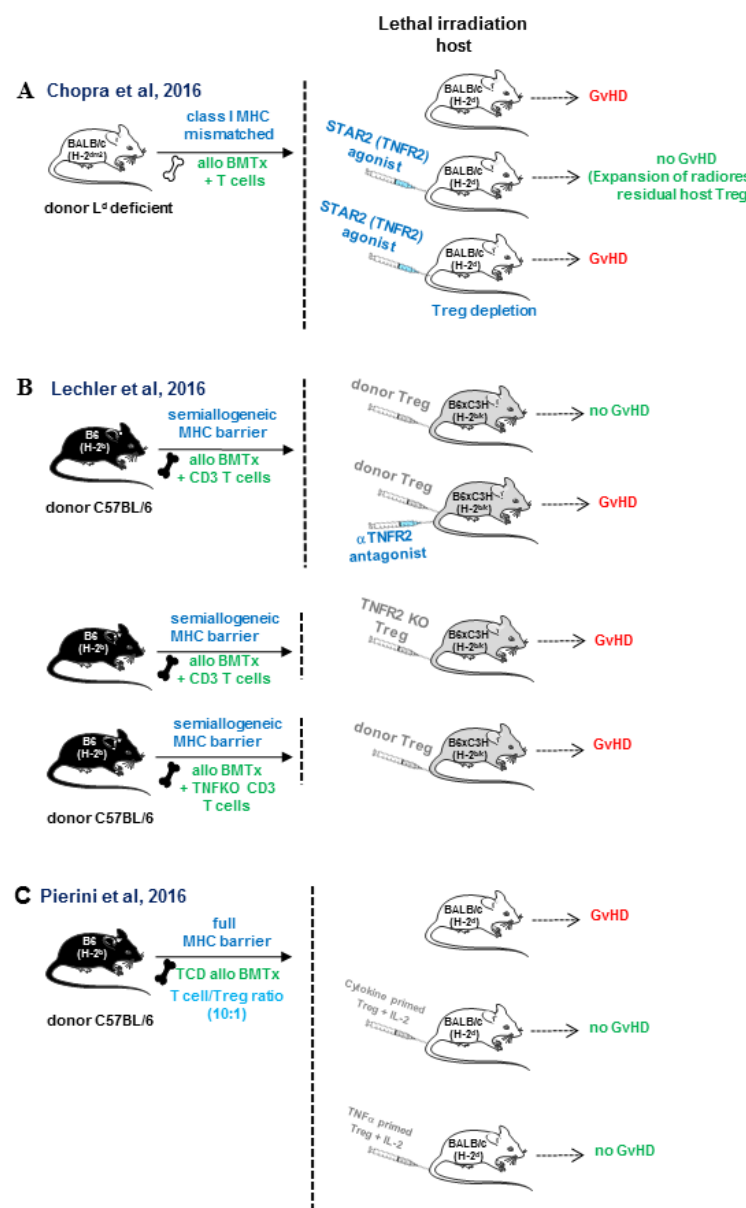
Figure 4. In vivo TNFR2 triggering protects against GvHD by enhancing donor and host Tregs expansion in allogeneic bone marrow transplantation across di ff erent histocompatibility barriers. ( A ) Chopra et al. made use of a multimeric recombinant TNFR2 agonist, termed STAR2 containing mutations, to prevent binding to TNFR1. They demonstrated that pretreatment of irradiated recipients with STAR2 peri-transplant expanded residual Tregs that attenuated GvHD and prolonged host survival. This protective e ff ect was abolished in TNFR2-deficient recipient mice and in recipient mice depleted of Tregs [95]. (B) Leclerc at al. demonstrated that TNFR2-deficient Tregs or antibody-mediated blockade of TNF/TNFR2 did not abolish the protective effect of Tregs on GvHD. Tregs functional activity depended on TNF production by conventional T cells co-transferred with the allogeneic bone marrow transplant [96]. (C) Pierini et al. showed that the preconditioning of donor-type Tregs ex-vivo with irradiated host peripheral blood undergoing acute GvHD (cytokine-primed) or primed with TNF in the presence of IL-2 attenuated GvHD at an unfavorable Tregs: T conventional ratio (1:10) [97]. In contrast, unprimed Tregs did not confer protection to GvHD development in a setting of allogeneic bone marrow transplantation across a fully MHC mismatched